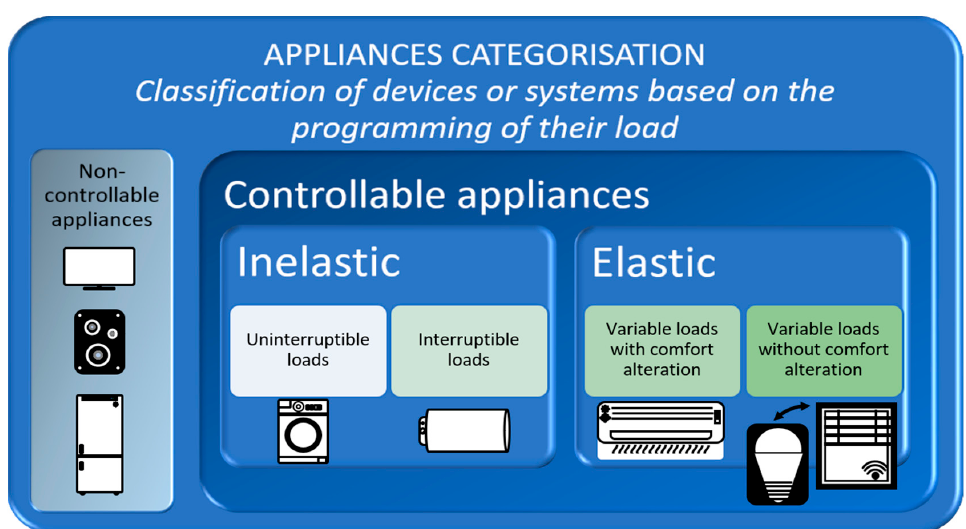
Figure 4. Classification of equipment or systems based on the programming of their load.